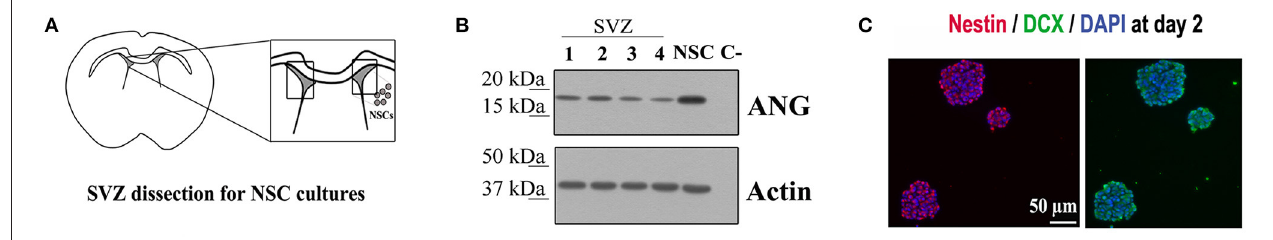
FIGURE 1 | Angiogenin expression in the SVZ niche: (A) schematic figure of the SVZ dissection for NSCs isolation. (B) Representative image of Western blot proving the presence of angiogenin in SVZ niche of different naïve mice and in primary NSCs in culture derived from the adult SVZ (see online Supplementary Material for the full-length Western blot film); (C) Neurosphere immunocytochemistry phenotyping showing expected nestin and DCX markers. ANG, angiogenin; C–, negative control (NSC culture media); DCX, doublecortin; NSCs, neural stem cells; SVZ, subventricular